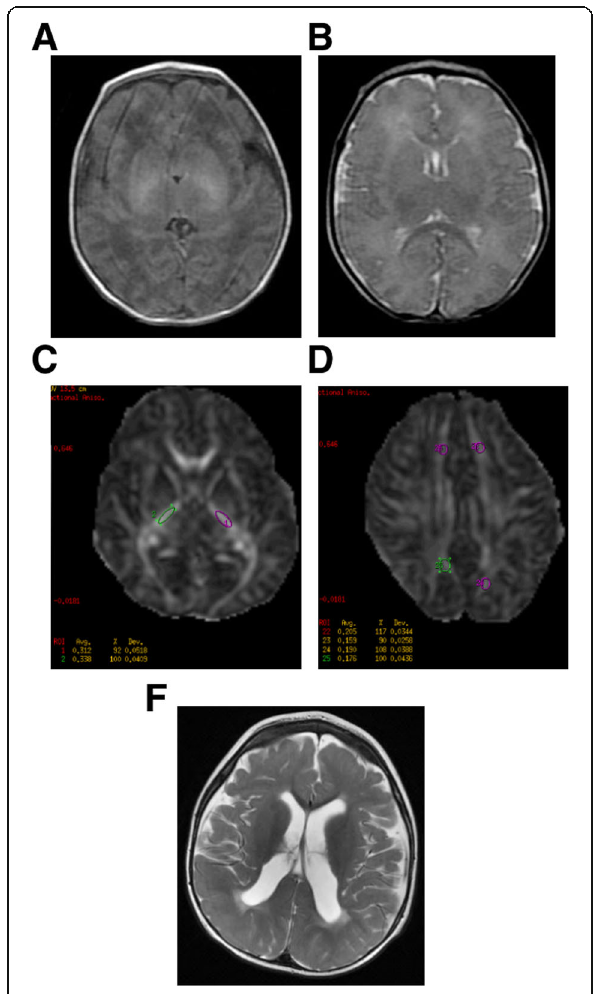
Fig. 4 Eleven days neonate presenting with severe HIE picture, Sarnat III with CP outcome. Conventional MRI: a , b axial T1 and T2 showed preserved PLIC signal. DTI: c , d posterior limb of internal capsule FA value = 0.31 and centum semiovale FA value = 0.20. Follow-up examination: e axial T2 showed thinning of the peri- trigonal white matter with undulated borders of the lateral ventricles (PVL picture). f Tractography showed mild thinning of